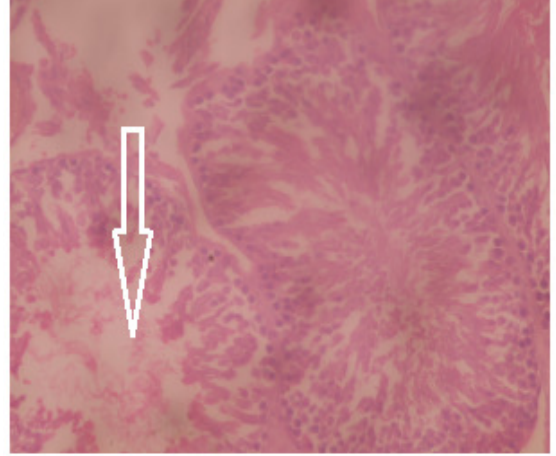
Fig. 2. Photomicrograph of transverse section of typical testicular tissue from group 2 rats (x400 magnification; H&E) Slide shows histologically distorted testicular tissue. Seminiferous tubule contains vacuoles with absent of mature spermatozoa with flagella